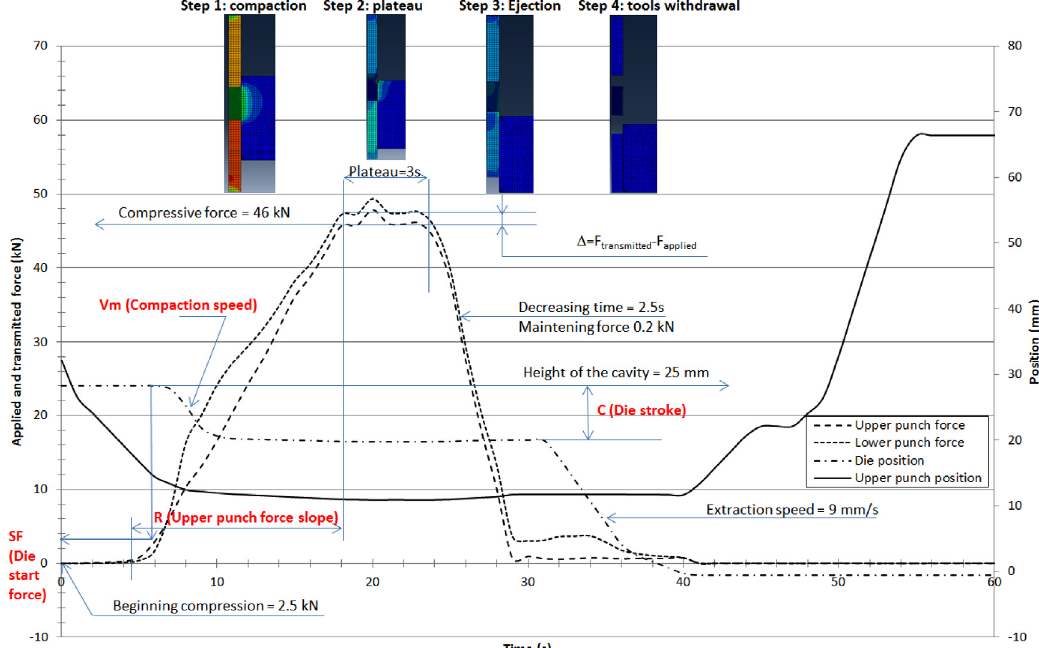
Fig. 1. Upper, applied and lower transmitted punch forces, die and upper punch displacements depending on time, Von Mises stresses during step calculations (1 to 4), corresponding to the compaction cycle.